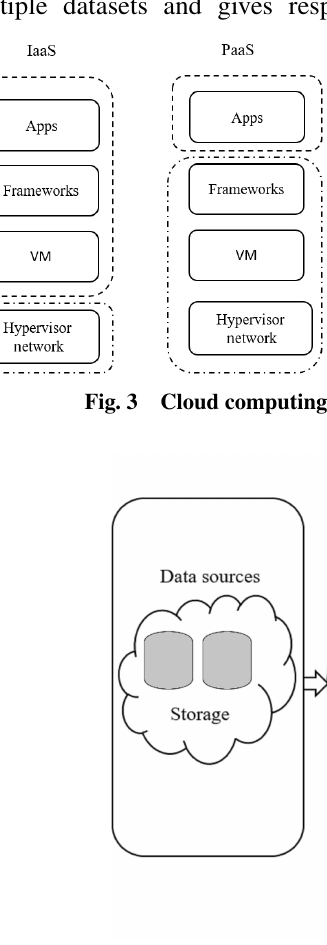
Fig. 4 Big data and cloud